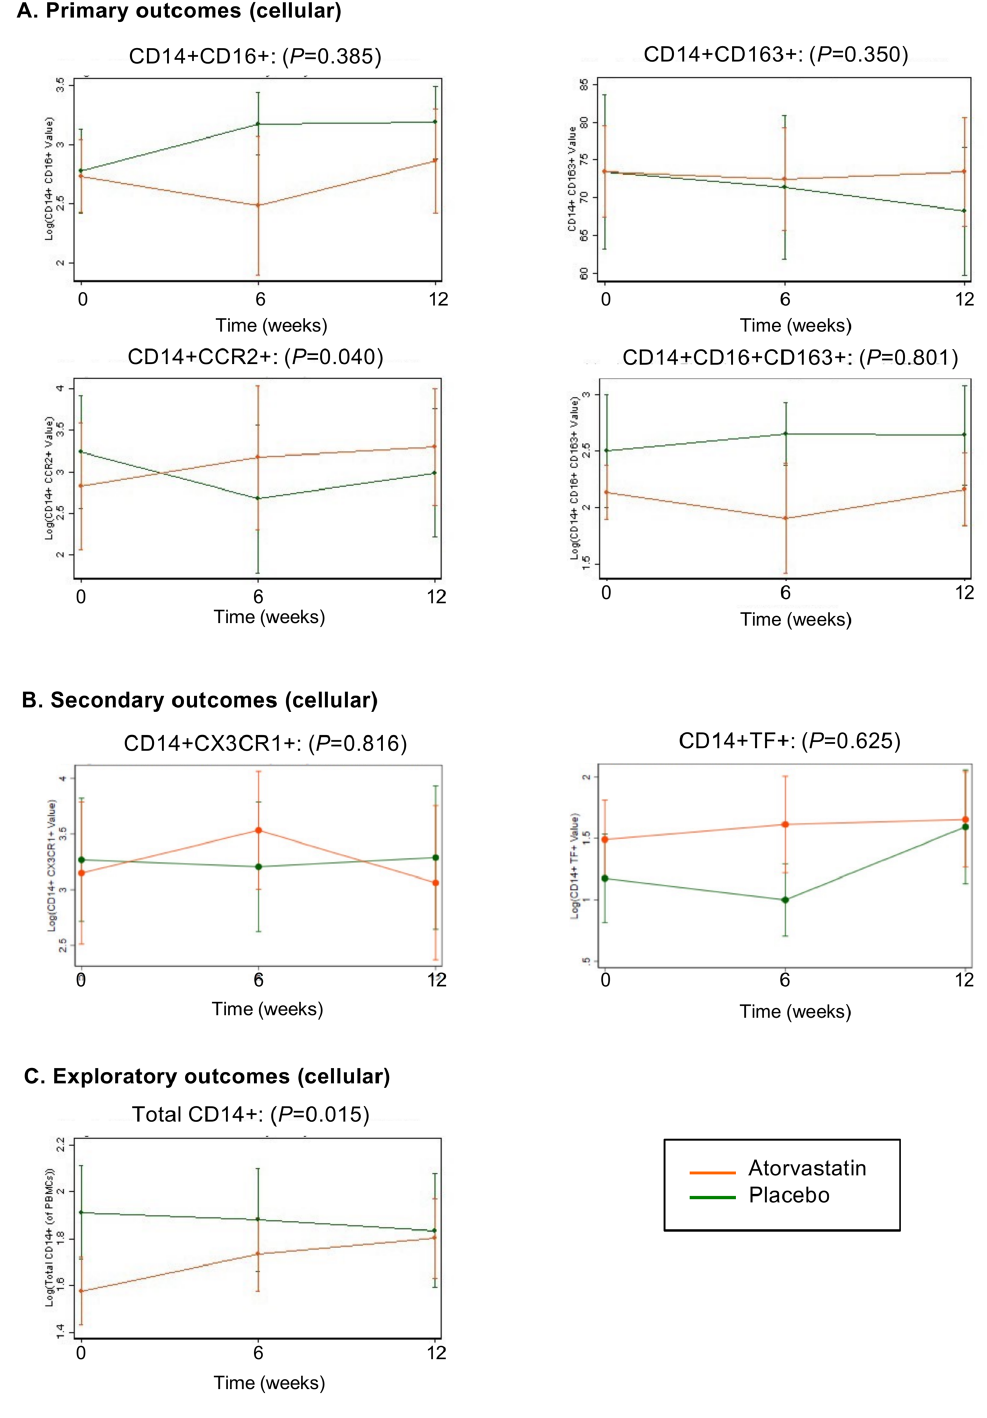
Figure 2. Effect of atorvastatin treatment on monocyte cell surface markers: Shown are the predefined primary outcomes (A) and secondary outcomes (B), along with exploratory outcomes that reached a nominal P ≤0.05 threshold (C). Data represent the mean biomarker levels by study arm with 95% confidence intervals, with atorvastatin shown in red and placebo in green. Raw P value of the difference between the 2 groups over 12 weeks is